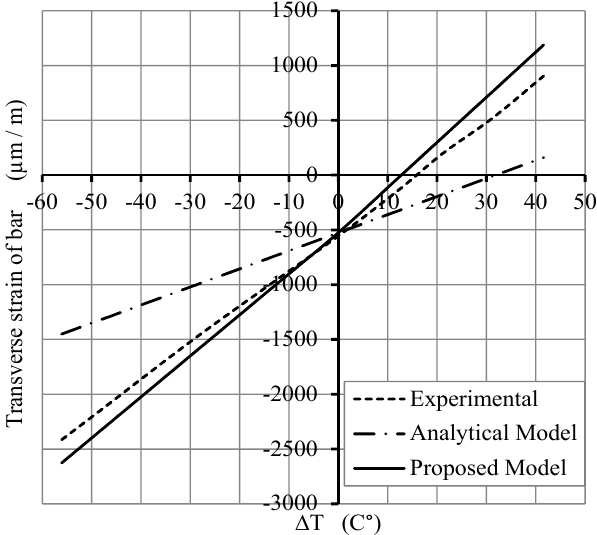
Figure 15. Transverse strain of FRP bars of slab SA.45.16—Experimental and analytical = results comparison, c/d b